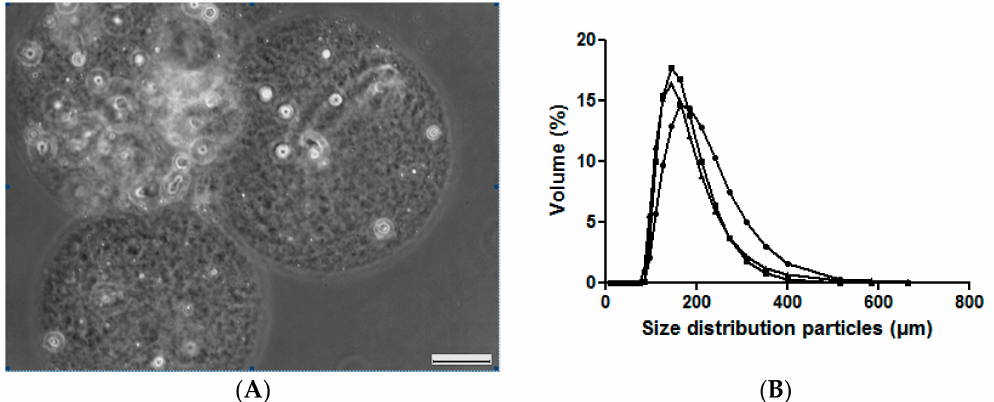
Figure 2. Characterization of the Si-HPMC particles. ( A ) Representative light microscopy image of the Si-HPMC particles produced using droplet-based millifluidics; ( B ) Size distribution of three batches of Si-HPMC particles produced using droplets-based millifluidics and as determined by laser diffraction. Scale bar: 50 µ m.